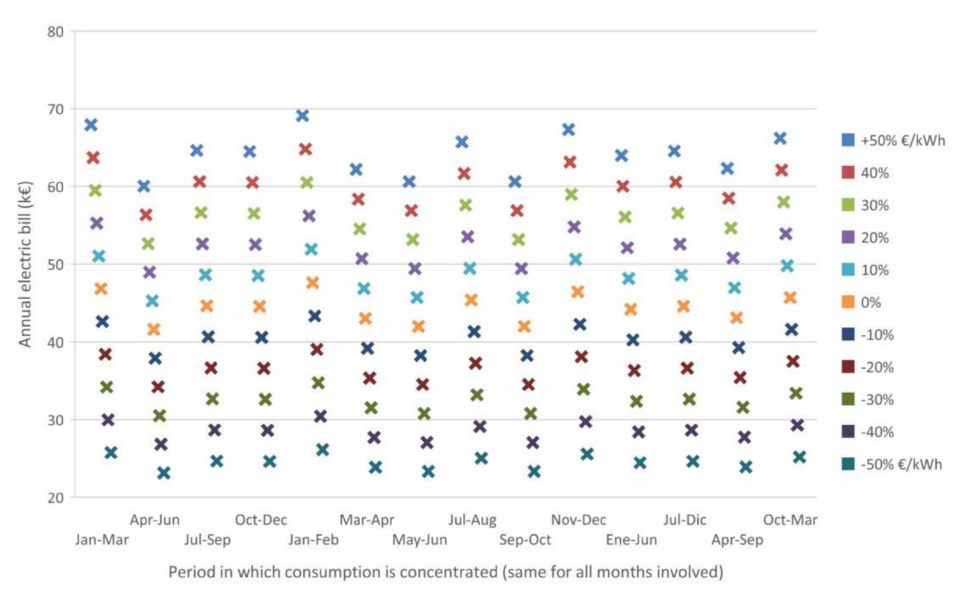
Figure 9. Amount of the annual bill of a fictitious industry with an annual consumption of 115,000 kWh, according to different consumption patterns: concentrated in the 4 seasons, in 2-month periods, and in 6-month